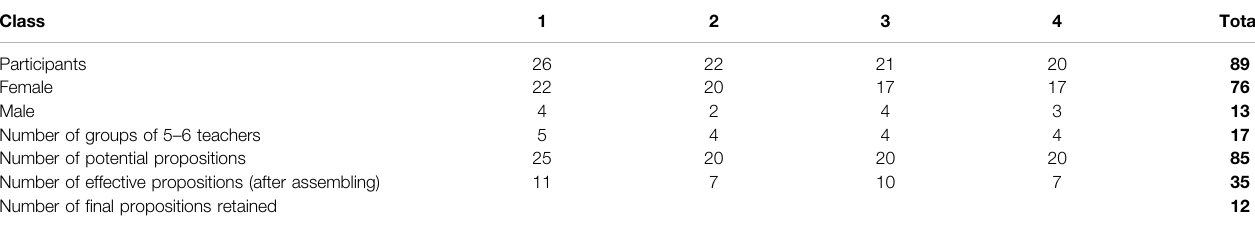
TABLE 1 | Main characteristics of the focus groups.